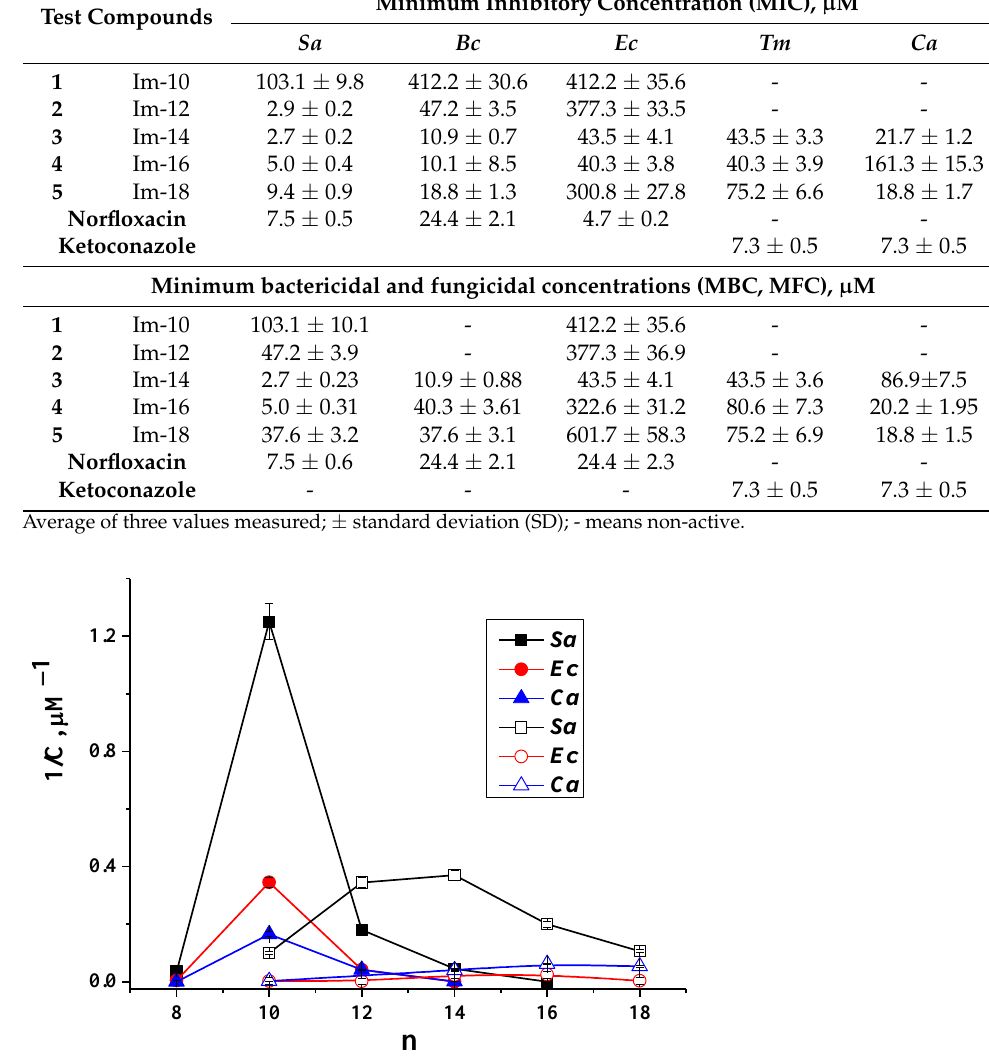
Table 2. Antimicrobial activity of monocationic imidazolium surfactants. Test Compounds